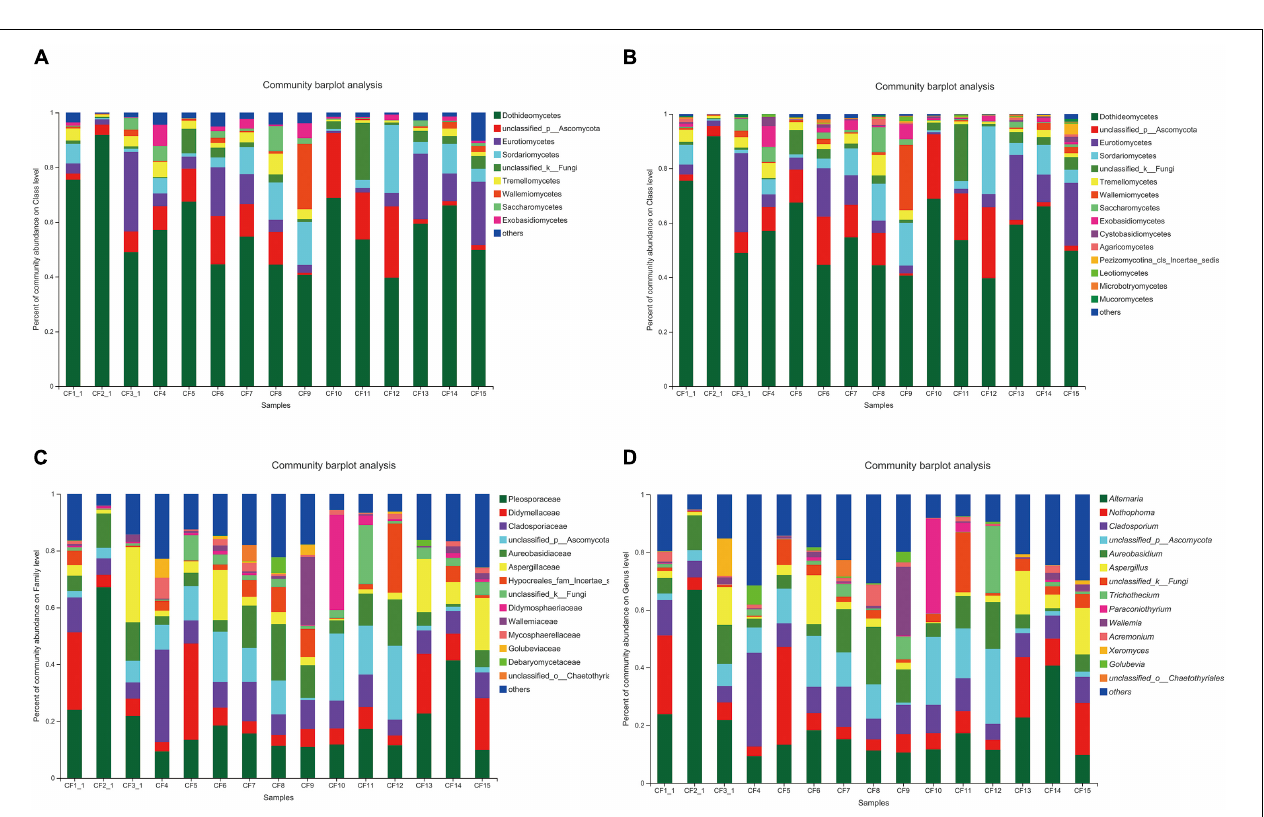
level ( Figure 4B ). Moreover, the abundances of Aspergillaceae, Pleosporaceae, and Microascaceae were highest at the family level, accounting for 1.29–29.74%, 0–67.17%, and 1.67–82.68%